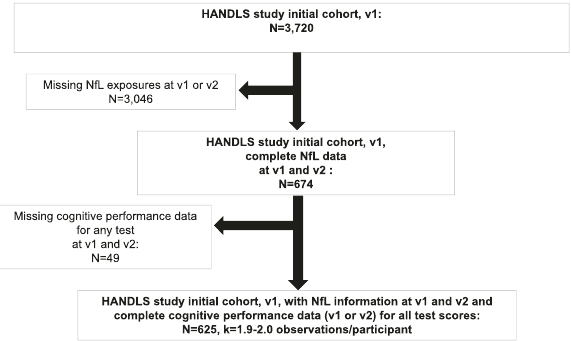
Fig. 1 Participant fl owchart. Abbreviations: HANDLS Healthy Aging in Neighborhoods of Diversity across the Life Span; k = # of observations/participant; NfL neuro fi lament light; v 1 visit 1; v 2 visit